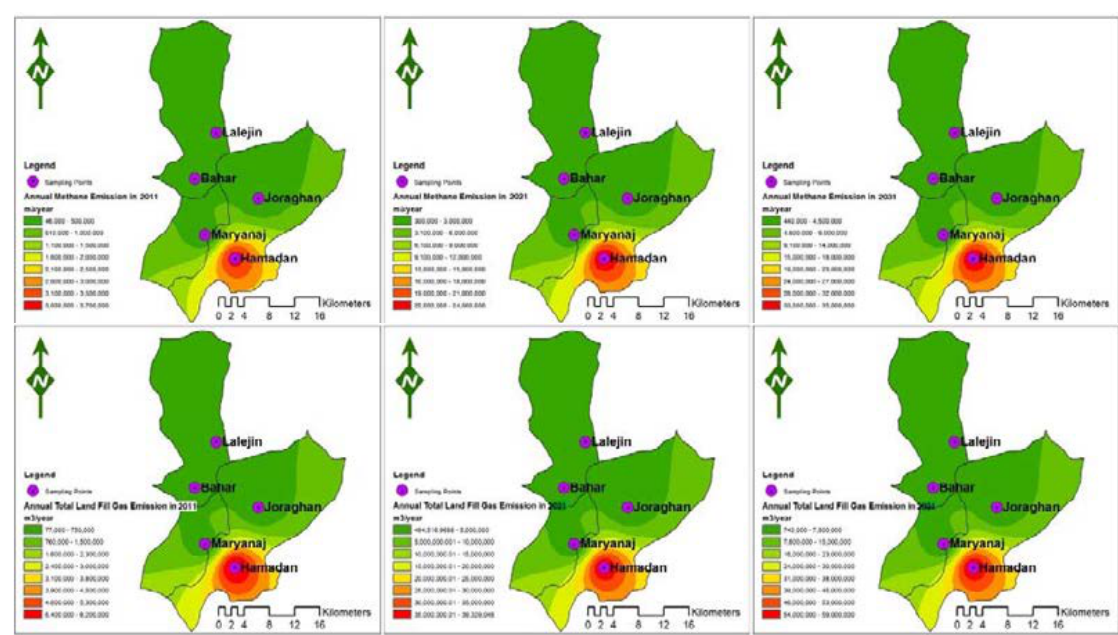
Fig. 7: Spatial distribution of annual methane and total landfill gas emission in two decades (2011-2021 and 2021-2031) in the studied area